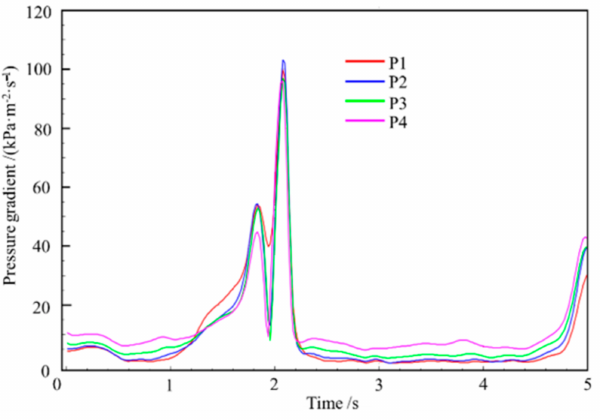
Figure 14. Pressure gradients at different heights of the vortex core center over